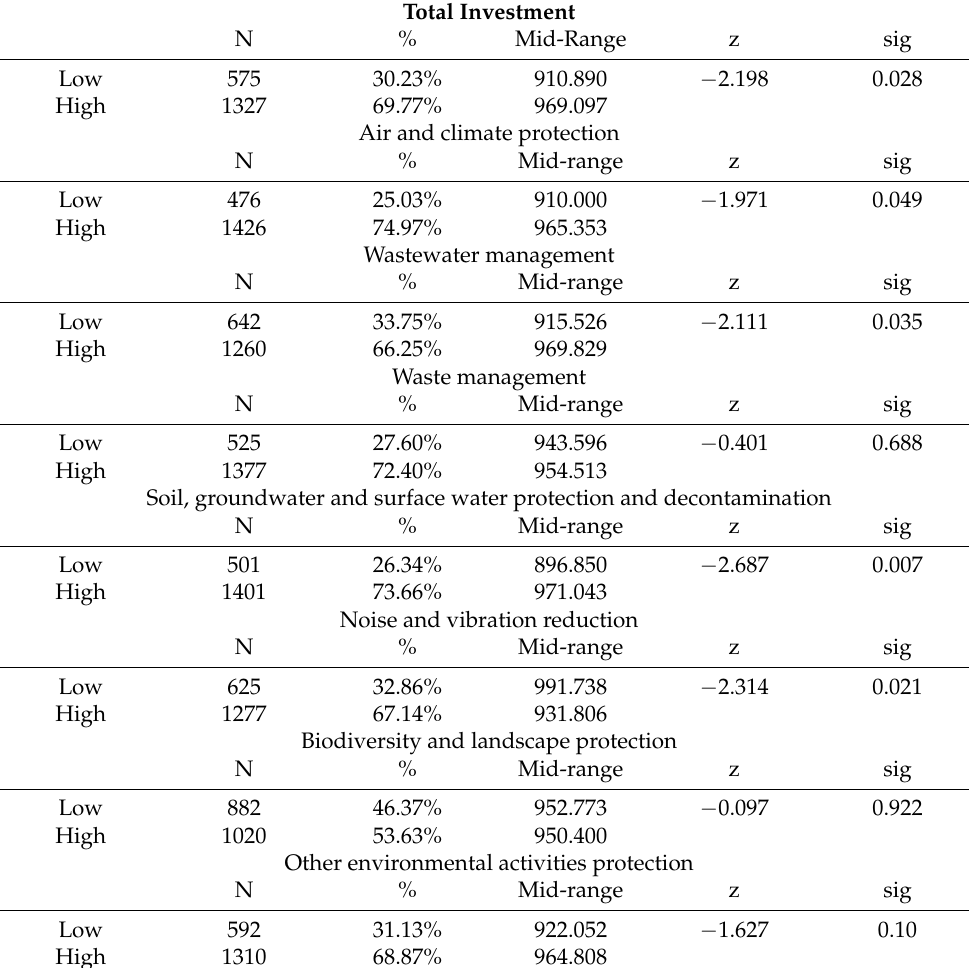
Table 12. The non-parametric tests (Mann–Whitney